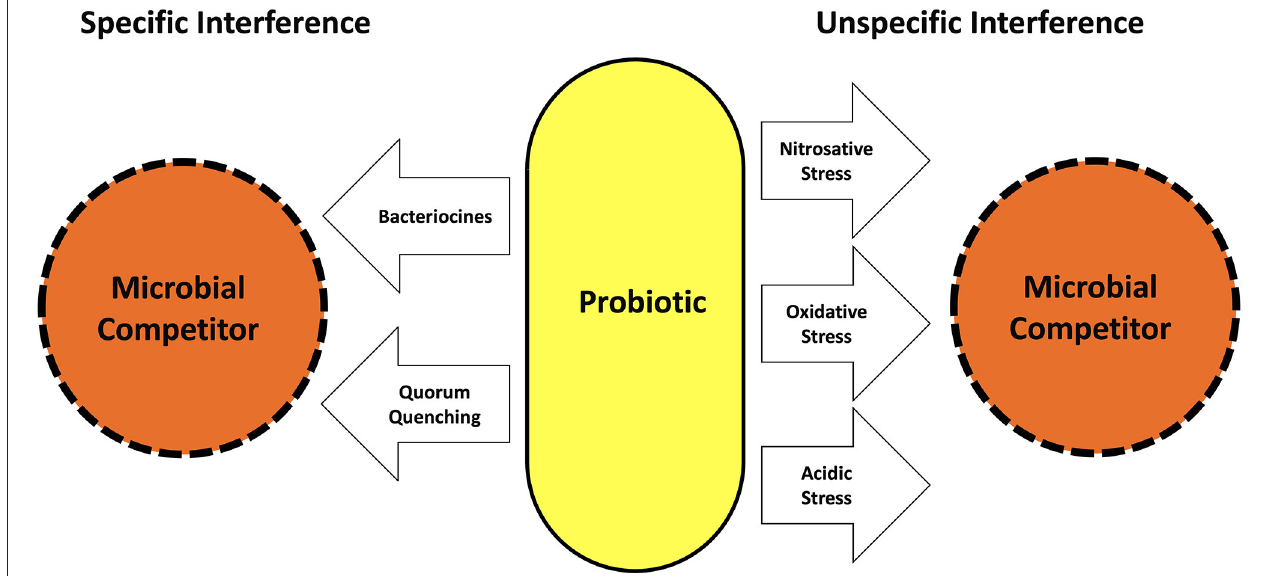
FIGURE 1 | Mechanisms used by probiotics to interfere with the growth and metabolism of competing microorganisms.